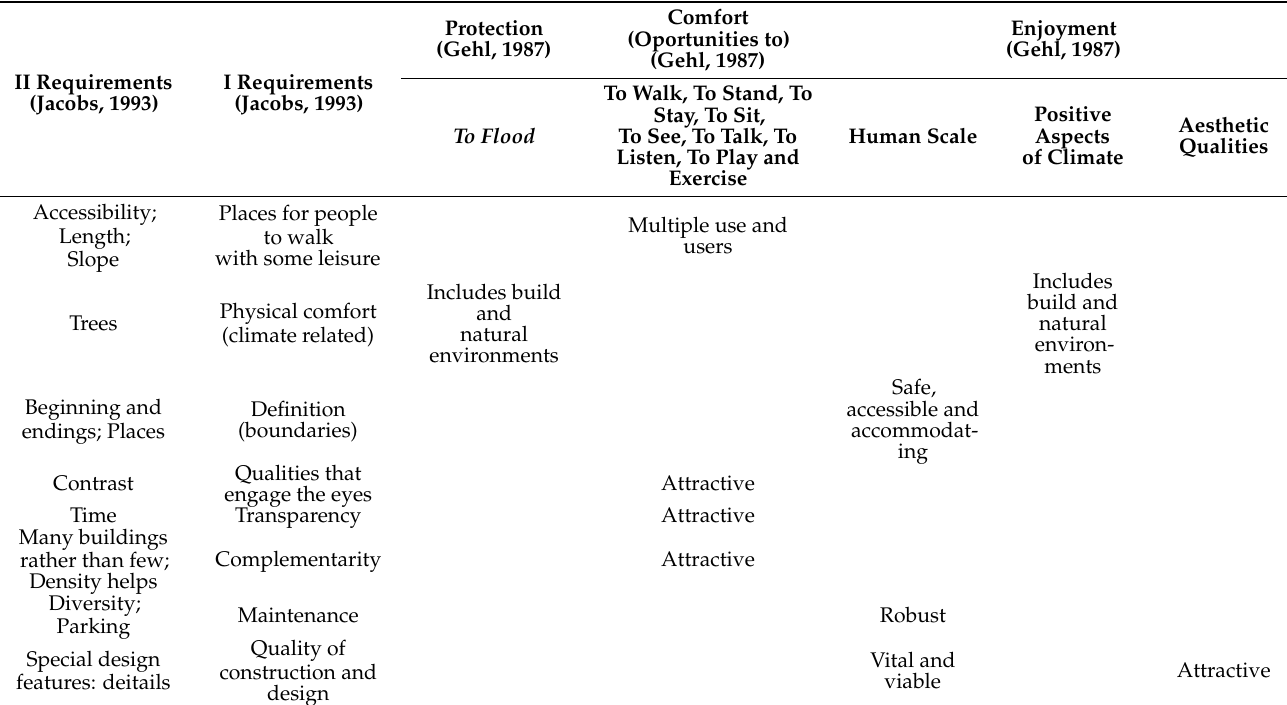
Table 6. Waterfront public space definition. Authors’s Edition. Source Data: